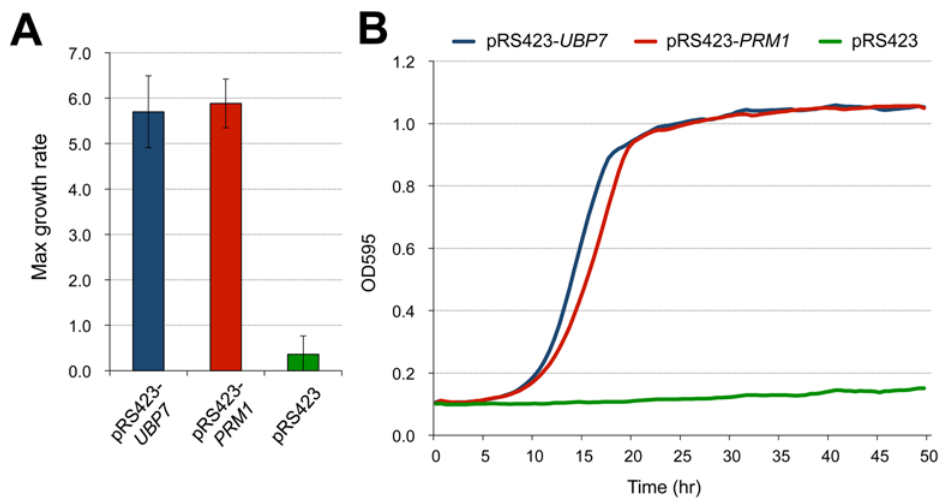
Fig 5. Multicopy suppressors of growth inhibition after increasing the copy number in the DIE2 3 0 fragment. A. Maximum growth rate of BY4741 cells that harbored both pTOW-Rear2 and the suppressor plasmids (pRS423- UBP7 and pRS423- PRM1 , and the empty vector, pRS423) in SC — Ura — His medium. The aver- ages and standard deviations from six independent experiments are